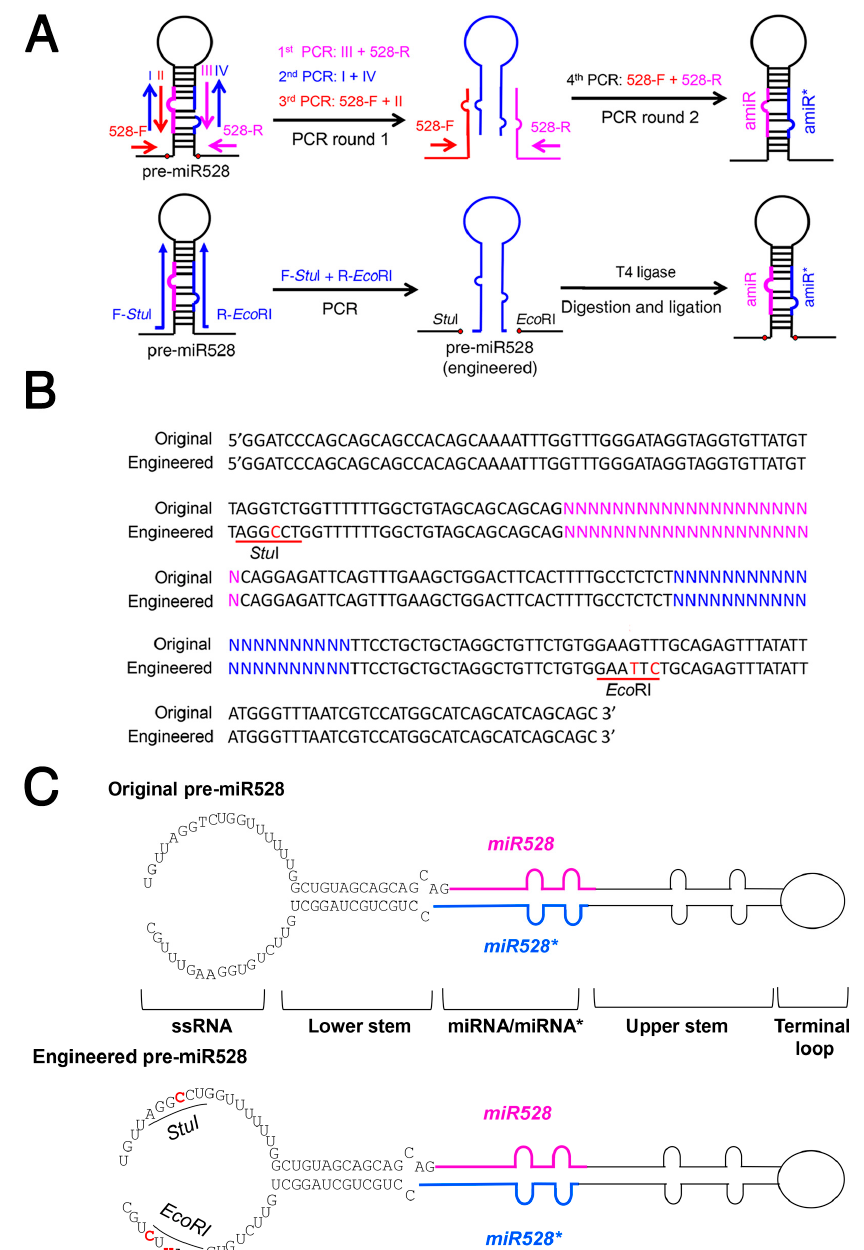
Figure 5. The engineered rice miR528 precursor allows a one-step construction of a new amiRNA precursor. (A) Diagram of amiRNA construction using the engineered miR528 precursor (pre-miR528). In the engineered pre-miR528, Stu I / Eco RI sites are created at the base of miR528 stem-loop. The amiRNA and amiRNA * are colored in magenta and blue, respectively. ( B ) The engineered pre-miR528 contains mutations that can create Stu I and Eco RI sites (underlined), respectively. The nucleotides in magenta and blue correspond to amiRNA and amiRNA * , respectively. ( C ) Diagram of the original and engineered pre-miR528. Mutated nucleotides are highlighted in red.